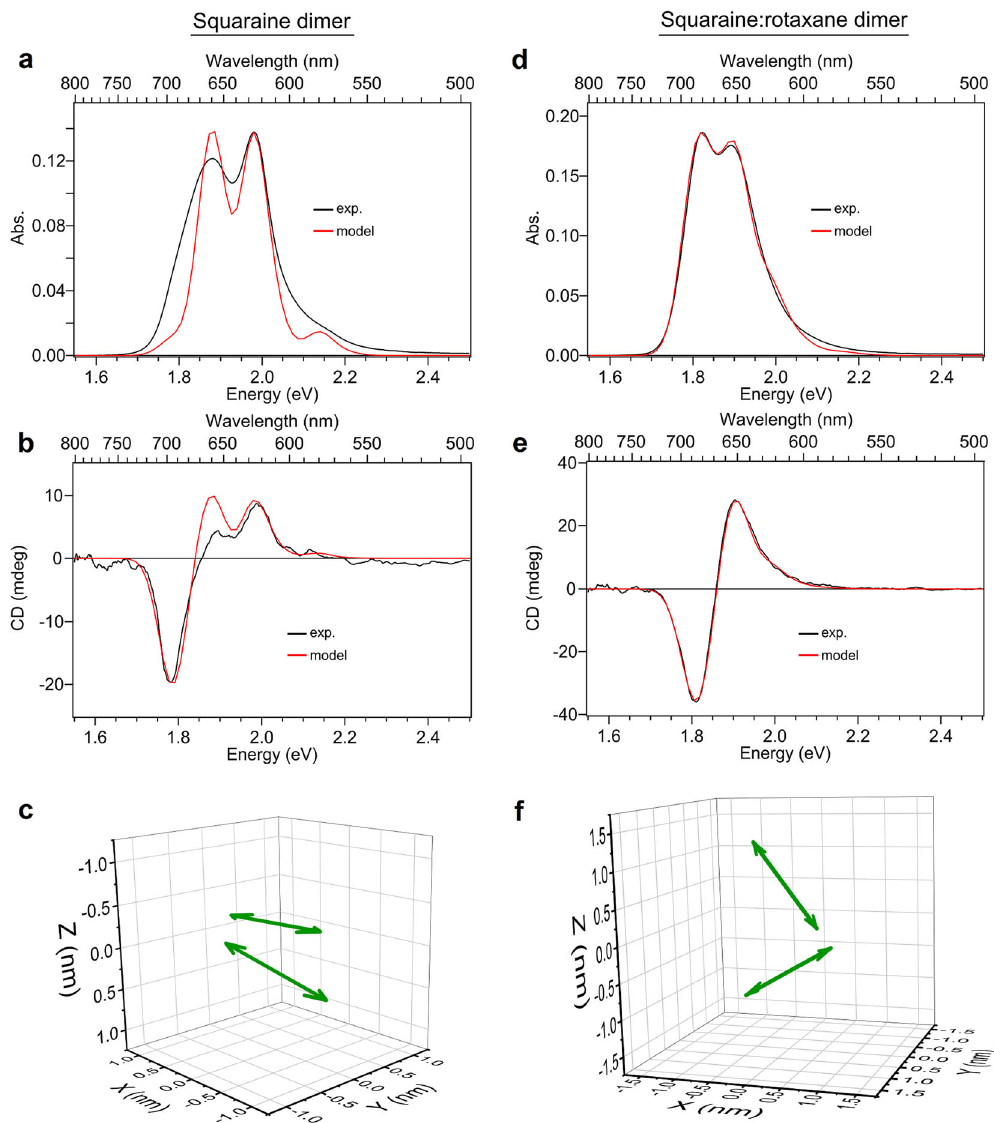
Fig. 3 KRM modeling of the dye packing in DNA-templated SQ and SR dimers. a , d Experimental (black) and simulated (red) absorption spectra for the SQ and SR dimer solutions. b , e Experimental (black) and simulated (red) circular dichroism spectra for the SQ and SR dimer solutions. c , f Transition dipole moments (TDMs) derived from the KRM modeling of the absorption and CD spectra. The TDMs corresponding to the two dyes in the dimer structure are shown as double-headed, green arrows, which are assumed to orient along the long axis of the dye. Additional projections of the TDMs along the XY, XZ, and YZ planes are provided in Supplementary Note